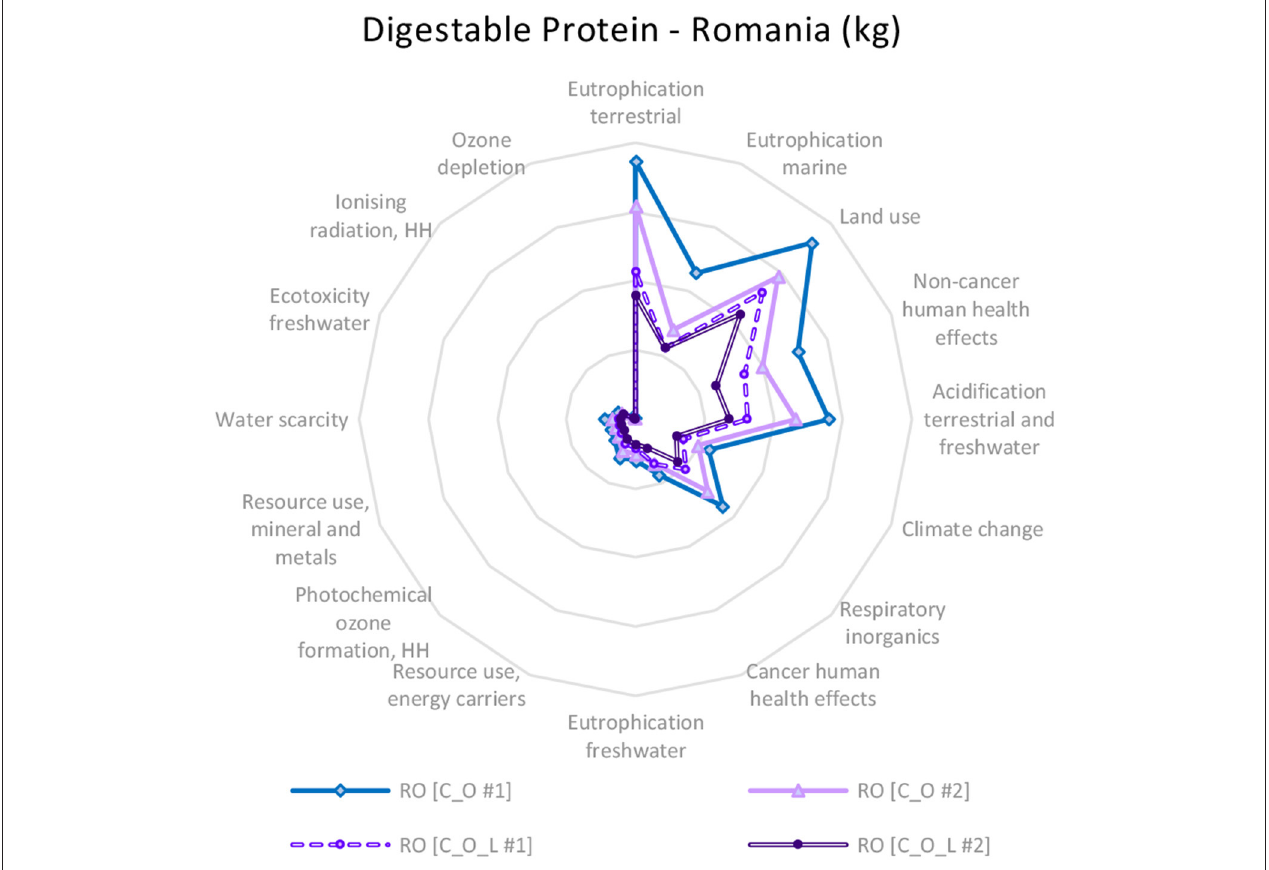
FIGURE 5 | Normalized environmental scores per kg digestible protein (DP) animal feed nutritional output across Romanian crop rotations. RO [C_O #1] refers to cereal-oilseed rotation option 1, RO [C_O #2] refers to cereal-oilseed rotation option 2, RO [C_O_L #1] refers to cereal-oilseed-legume rotation option 1 (with common beans) and [C_O_L #2] refers to cereal-oilseed-legume rotation option 2 (with